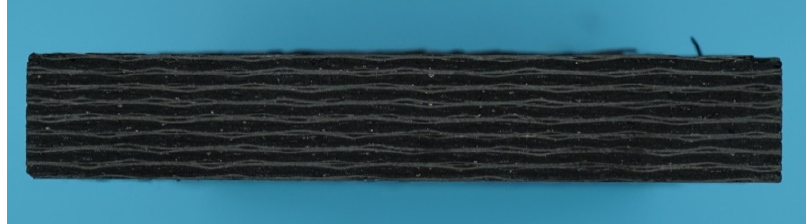
Figure 10. Number of plate layers.